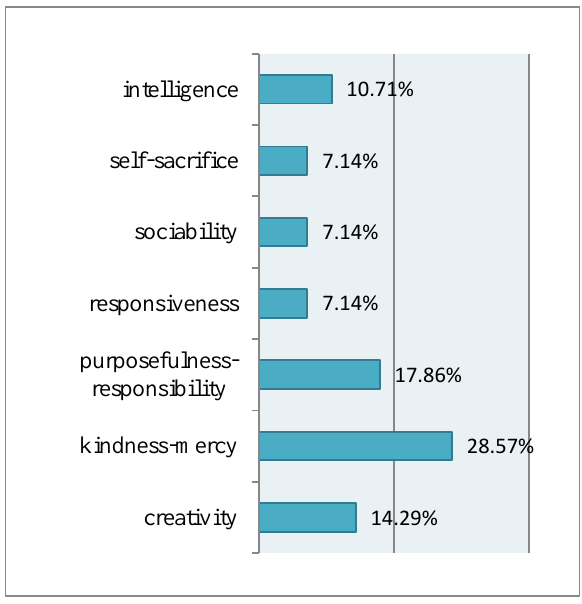
Fig. 4. According to the respondents, the most valuable human quality that inspires pride in